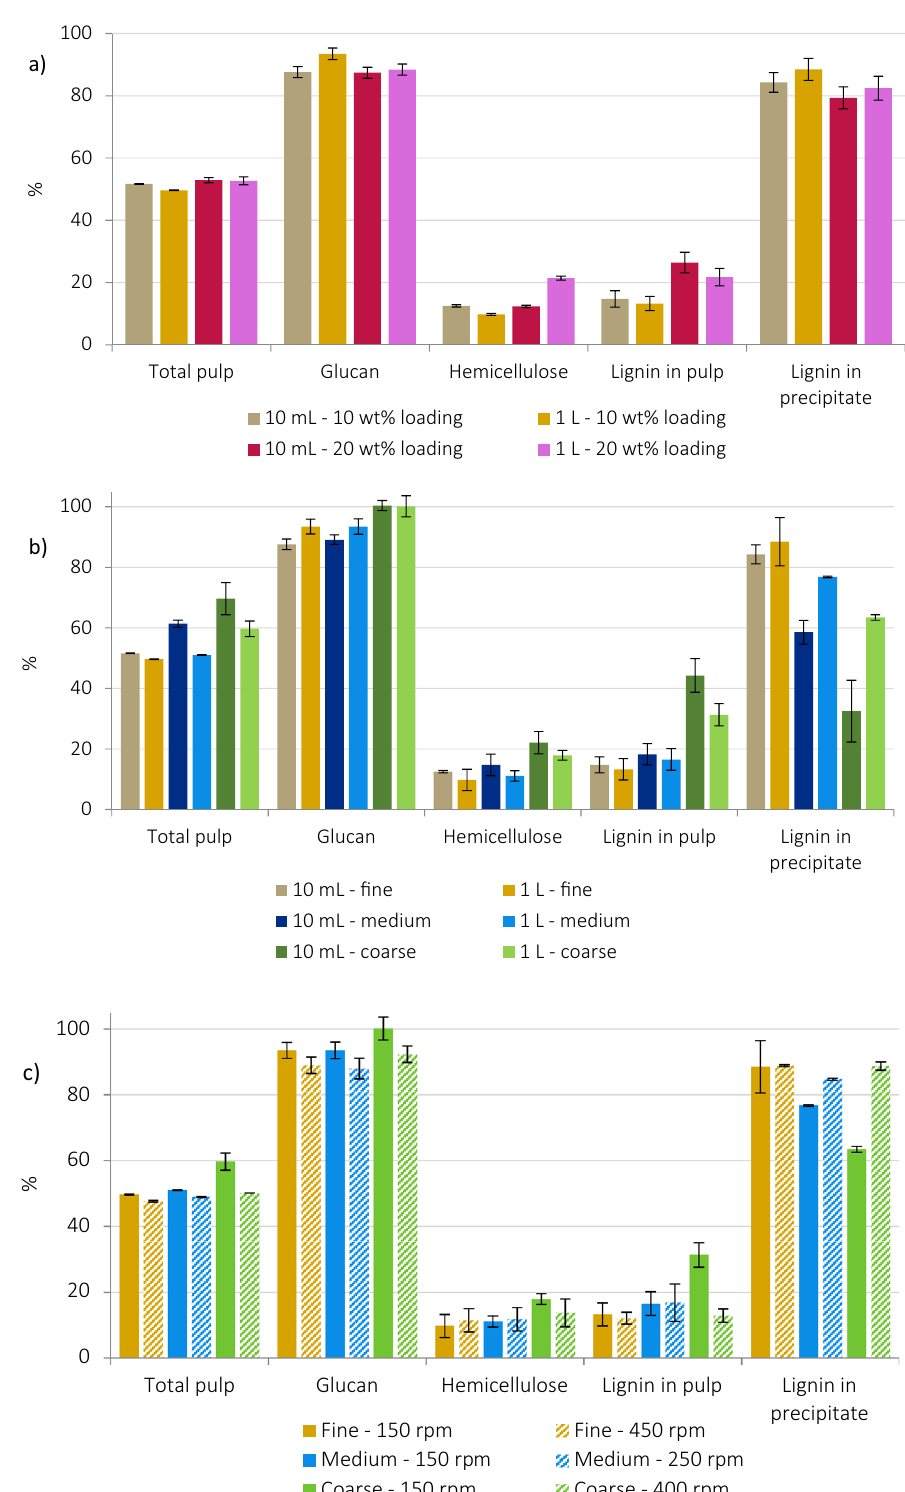
Figure 6. Comparisons of total solids (i.e. pulp), glucan, hemicellulose and lignin recovered in the pulp, and lignin precipitate yield ( a ) upon 100-fold scale-up for 10 and 20 wt% solid loading. Results shown as a proportion of component amount in untreated Miscanthus ; ( b ) for fine, medium and coarse particle sizes. Results shown as a proportion of component amount in untreated Miscanthus ; ( c ) for fine, medium and coarse particle sizes as a function of stirring speed. Results shown as a proportion of component amount in untreated